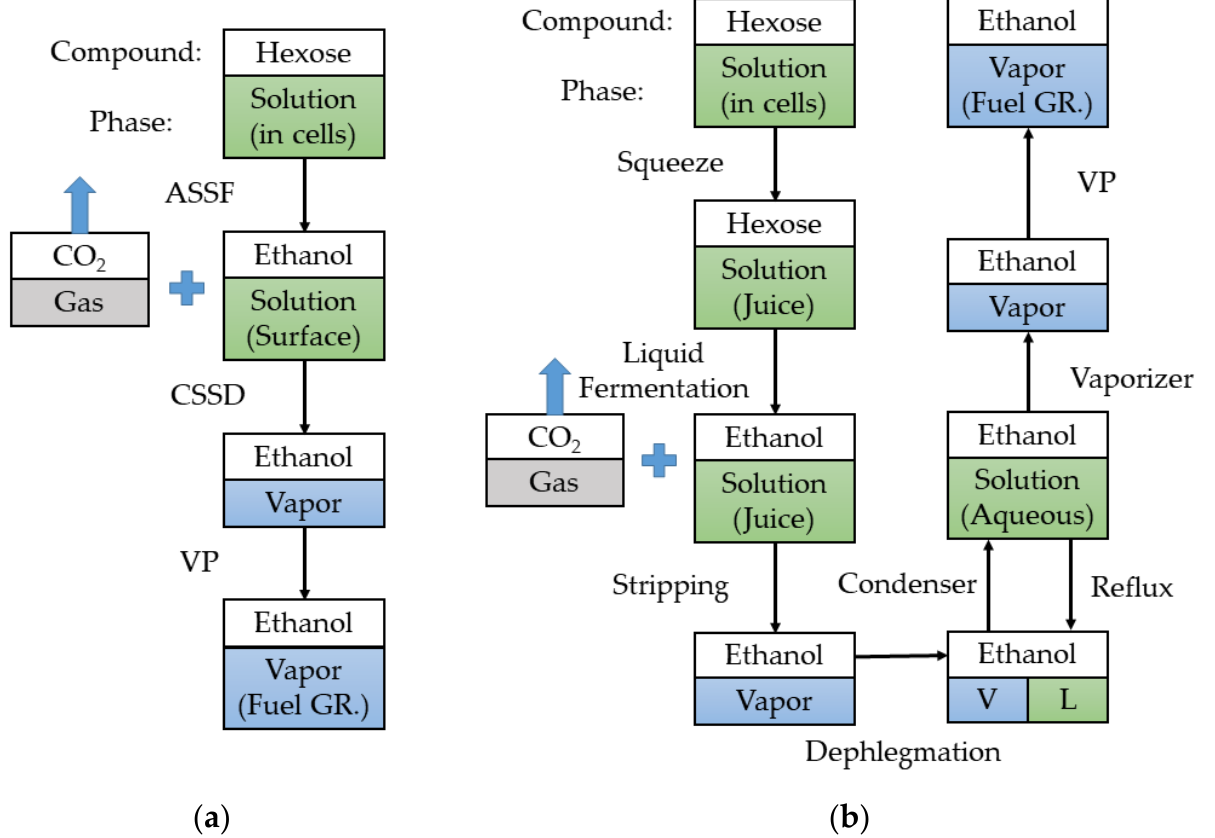
Figure 4. Mass transfer roadmap of solid-state fermentation and liquid fermentation for fuel grade bioethanol production ( a ) OPTS process. ( b ) Liquid fermentation combined with membrane-assisted vapor stripping process.